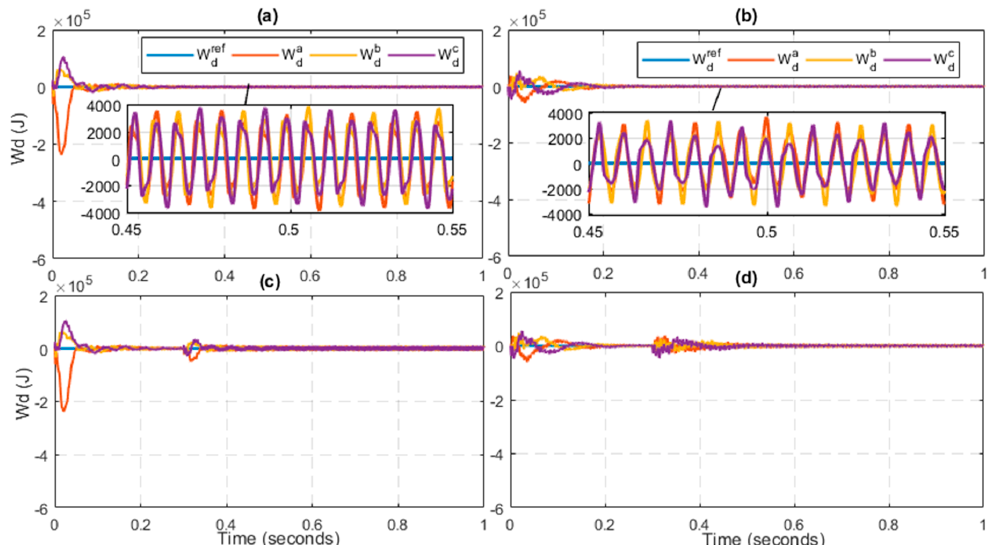
Figure 6. Energy difference ( a ) Proposed controller with constant reference; ( b ) PR controller with constant reference; ( c ) Proposed controller with stepped reference; ( d ) PR controller with stepped reference.